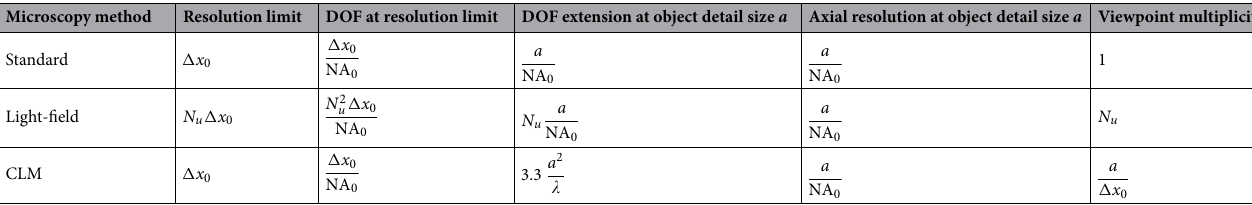
Table 1. Comparison of resolution and DOF limits of three microscopy techniques: standard microscopy (with no directional resolution), standard light-field microscopy, and CLM. Here, (cid:31) is the light wavelength and � x 0 = 0.61 (cid:31) / NA 0 the diffraction-limited resolution cell, with NA 0 the numerical aperture of the microscope. N u is the number of directional resolution cells per side in standard light-field imaging, and a is the size of the smallest details within the sample. The first and second columns represent the resolution limit in the focal plane and the maximum DOF achievable for objects with details at the resolution limit, respectively. The third column indicates the maximum DOF achievable for objects with detail size a > � x 0 larger than the resolution limit. The fourth column represents the axial resolution for objects of detail size a , which, as shown in the “Materials and methods” section, does not depend on the specific technique. The last column reports the number of viewpoints per direction. Properties of the light-field microscope are derived by the general features of light-field imaging devices (see Ref. 46 for a detailed discussion), while the resolution and DOF limits in CLM are derived from the theoretical analysis reported in Ref. 44 , as well as in the “Materials and methods” section. Notice that all the quantities are evaluated in the limit of small displacements with respect to the objective focal